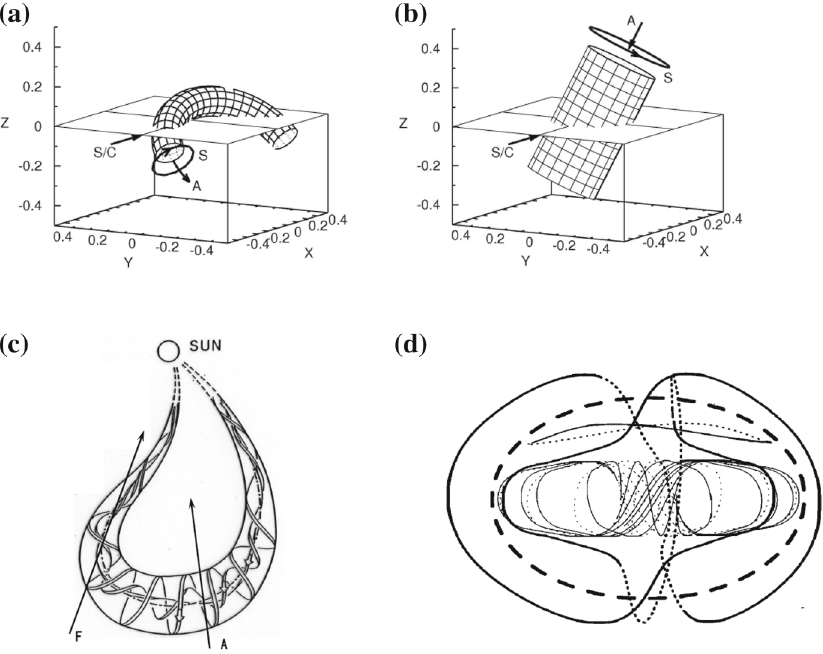
Fig.15 Geometriesforamagneticcloudof19March2001asobtainedfrom a torusmodeland b cylindrical model. The arrows denote the direction of magnetic field on the surface of the (S), the direction of the axial field, and (A) and the spacecraft trajectory (S/C). c Curved flux rope loop featuring the central but (path A) and the flank encounter (path F) with a double crossing through the axis. d Spheroidal oblate flux rope. The solid (dashed) lines depict the magnetic field lines above (below) the plane of the figure. The thick line shows the reference ellipsoid. Panels ( a )–( c ) reproduced by permission from Marubashi and Lepping (2007), copyright by the authors; panel ( d ) from Vandas et al. (1993), copyright by